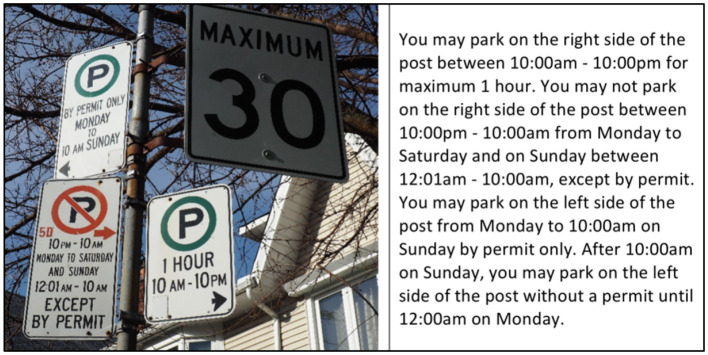
Example of sign explanation in parking instructions booklet provided to the participants.